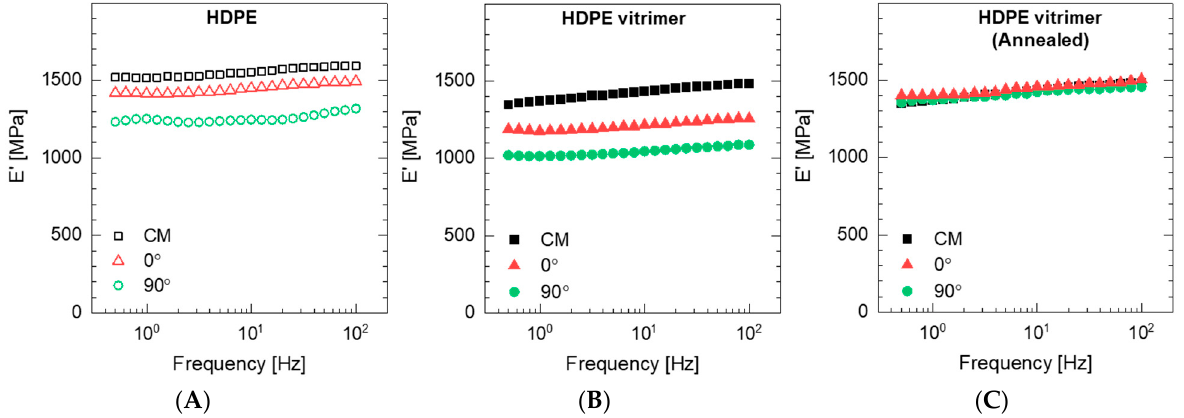
Figure 8. DMA frequency sweeps of compression-molded (CM) samples and 3D-printed specimens with loading parallel to the bead orientation (0°) and perpendicular to the bead orientation (90°): ( A ) HDPE, ( B ) HDPE-V, and ( C ) HDPE-V after an annealing process.